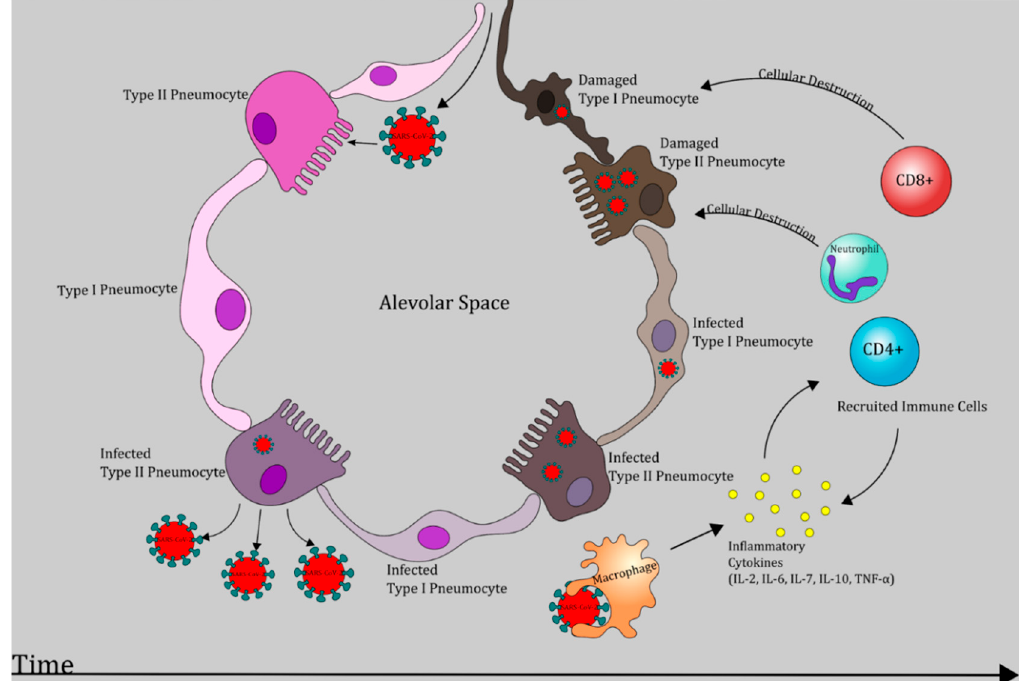
Figure 2. SARS-CoV-2 induced pathogenesis in the lungs. Chronological representation of SARS-CoV-2 progression leading to necrosis of type I and type II pneumocytes which may manifest as respiratory dysfunction and acute respiratory distress syndrome (ARDS) [6,27].